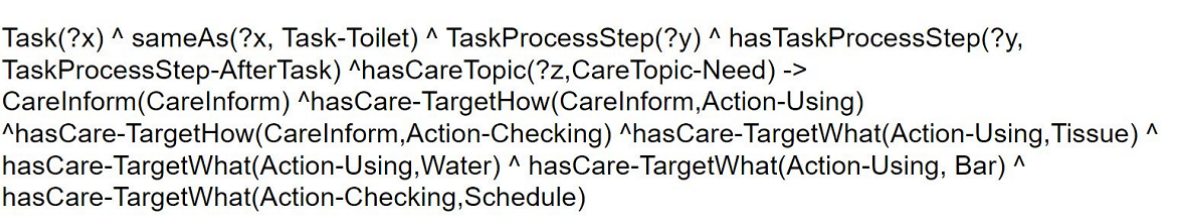
Figure 2. Example of Semantic Web Rule Language rule about Task-Toilet